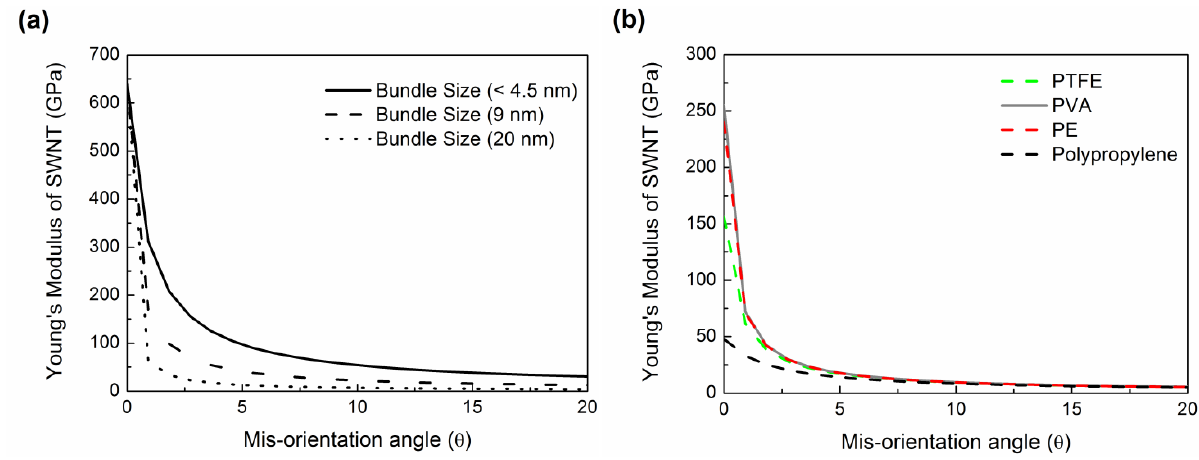
Figure 11. Graph showing the effect of mis-orientation on the effective Young’s modulus for both ( a ) SWNT fillers and ( b ) various linear polymers.